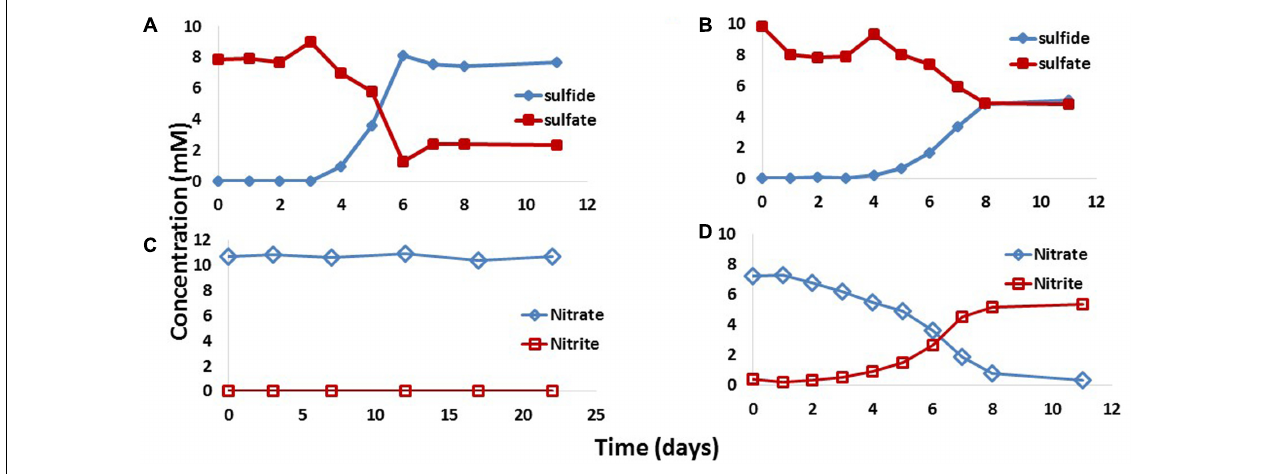
FIGURE 2 | Activity of tSRB and tNRB observed with 50-fold concentrated inocula of Terra Nova produced water PW1\_14 and injection water IW1\_14. Incubations were with PW1\_14 with 10 mM sulfate and 20 mM lactate (A) , PW1\_14 with 10 mM sulfate and 3 mM VFA (B) , PW1\_14 with 10 mM nitrate and 20 mM lactate (C) and IW1\_14 with 10 mM nitrate and 20 mM lactate (D) . Data are averages of duplicate